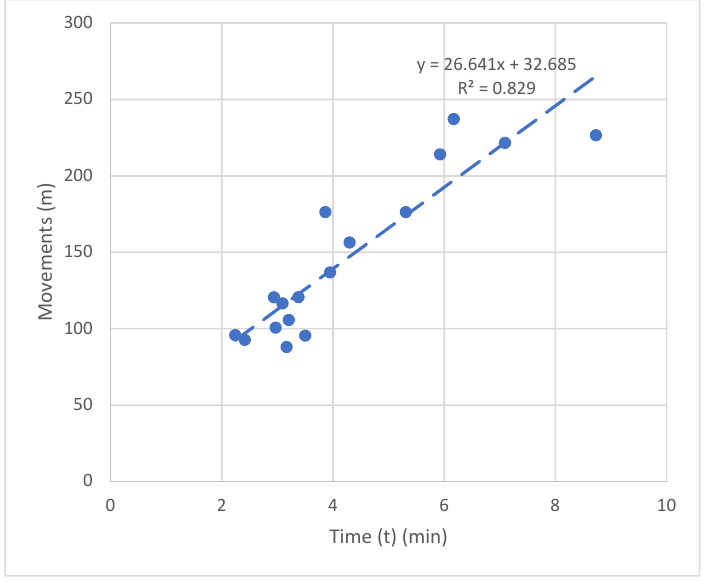
Figure 19. Relationship between time and the number of total movements completed. The information transfer rate (ITR) was used to evaluate the performance of the BCI system [8,133]. The calculation was made according to Equation (2), where T is equal to the stimulus time (7 s) plus the gaze change time (4 s); N is the number of stimuli, which in this case was three, and P is the precision of the classification (Table 4).